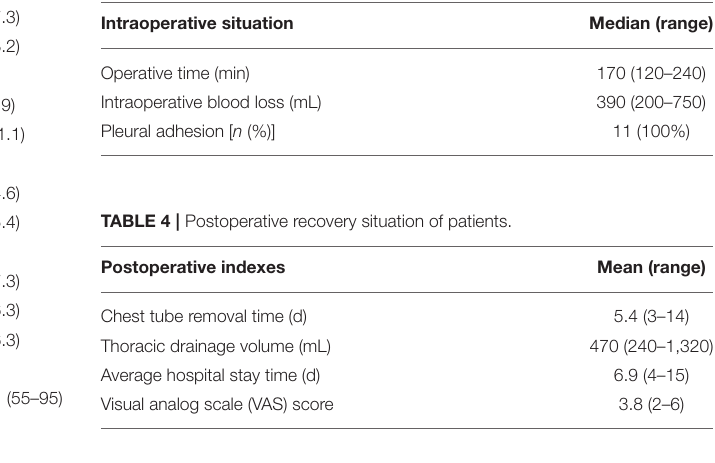
TABLE 3 | Intraoperative situation of patients.